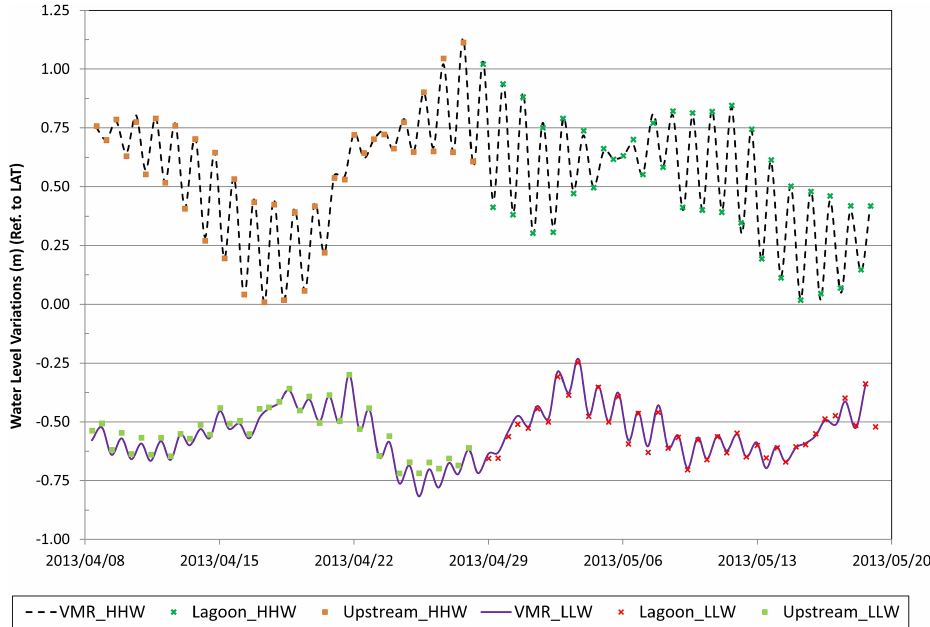
Fig. 4. Daily extreme water levels at the creek’s stations for highest high water (HHW) and lowest low water (LLW).